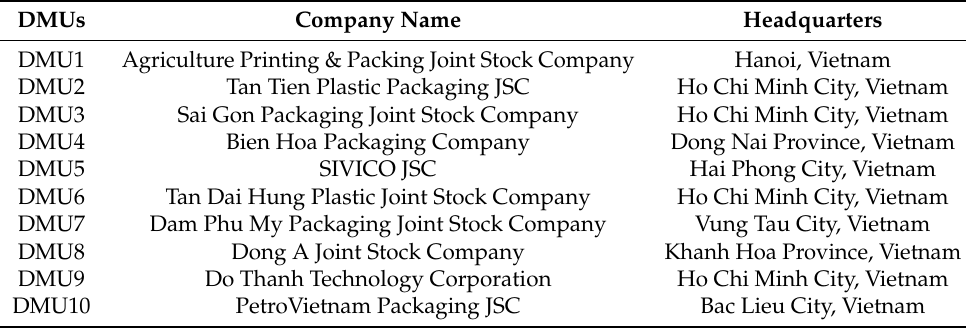
Table 1. List of packaging